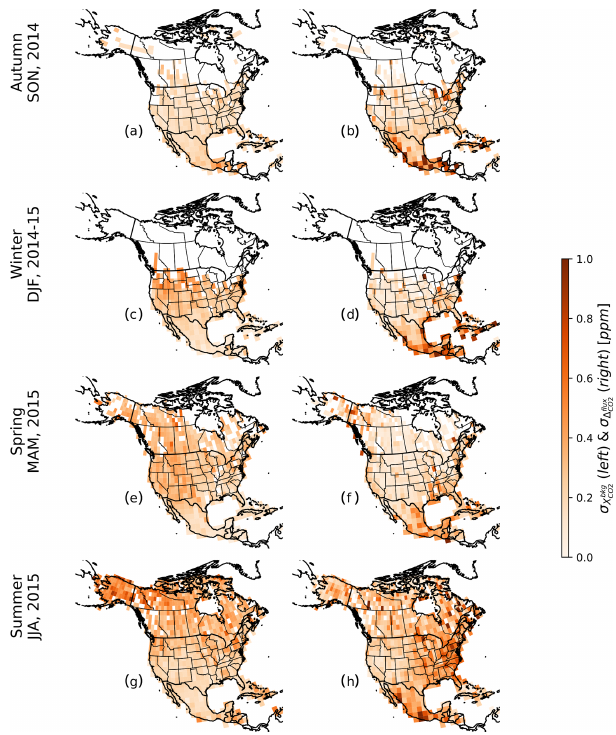
Figure 5. Cross-model standard deviations flux impact (a, c, e, g) and background models (b, d, f, h) . A total of six biospheric flux ensembles and four model fields for background are used in this